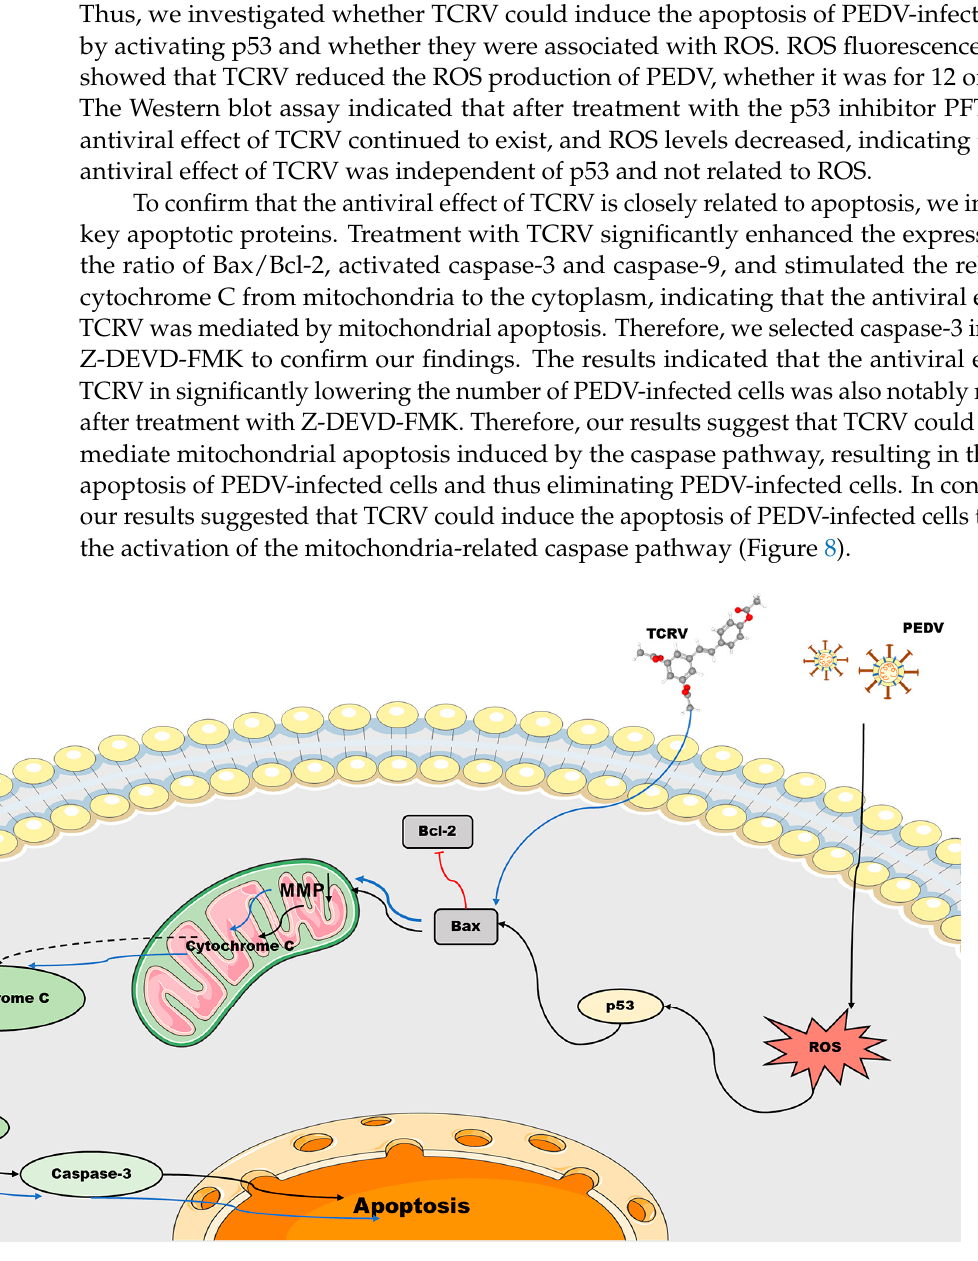
Figure 8. Model of apoptosis induced by the treatment of PEDV-infected Vero cells with TCRV. PEDV activates p53 to produce ROS and causes caspase-mediated mitochondrial apoptosis. TCRV directly mediates mitochondrial apoptosis induced by the caspase pathway, resulting in the early apoptosis of PEDV-infected cells and thus eliminating PEDV-infected